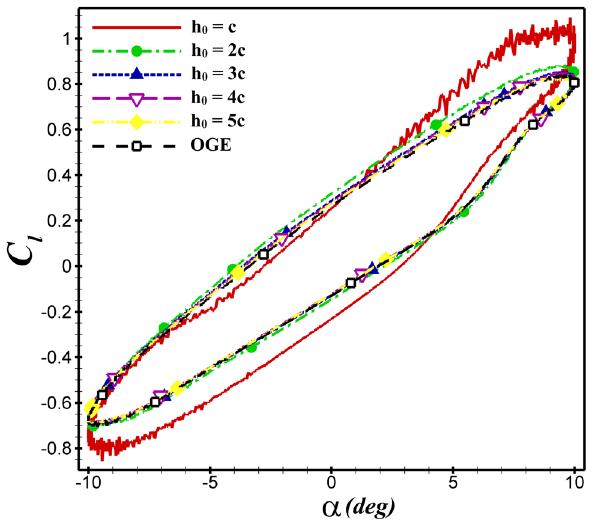
Figure 10. The C l of dragonfly airfoil in different h 0 over one oscillation period.